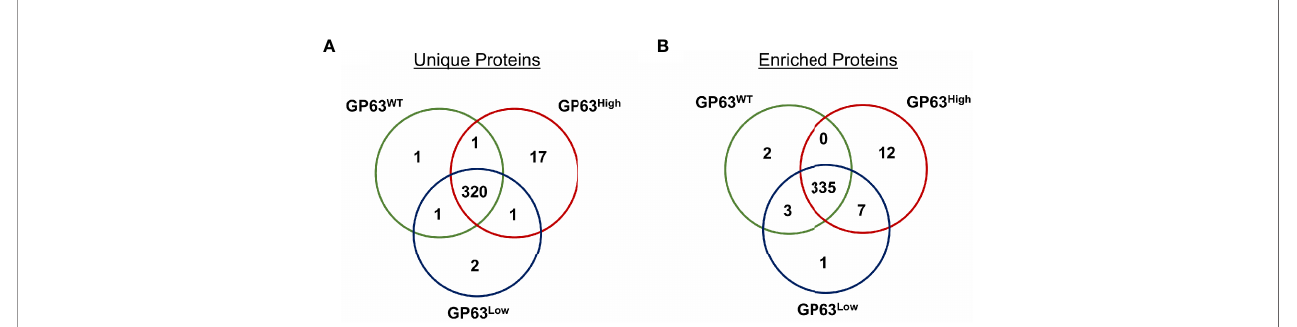
FIGURE 2 | Proteomic analysis of Leishmania amazonensis GP63 WT , GP63 High, and GP63 Low -derived EVs by Mass Spectrometry showed unique and enriched proteins. (A) Venn diagram showing the number of shared proteins between LeishEXO GP63 WT , LeishEXO GP63 High, and LeishEXO GP63 Low as well as the number of unique proteins of each of the 3 vesicle populations. LeishEXO GP63 High had the highest number of detected unique proteins; (B) Venn diagram showing the number of shared proteins found to be enriched in each of the 3 vesicle populations as well as the number of proteins with stable levels of detection between the 3 groups. LeishEXO GP63 High was found to have the highest number of enriched proteins. ANOVA analysis without corrections with the signi fi cance level as p<0,05; Mass spectrometry data analysis performed using Scaffold 4 ™ .